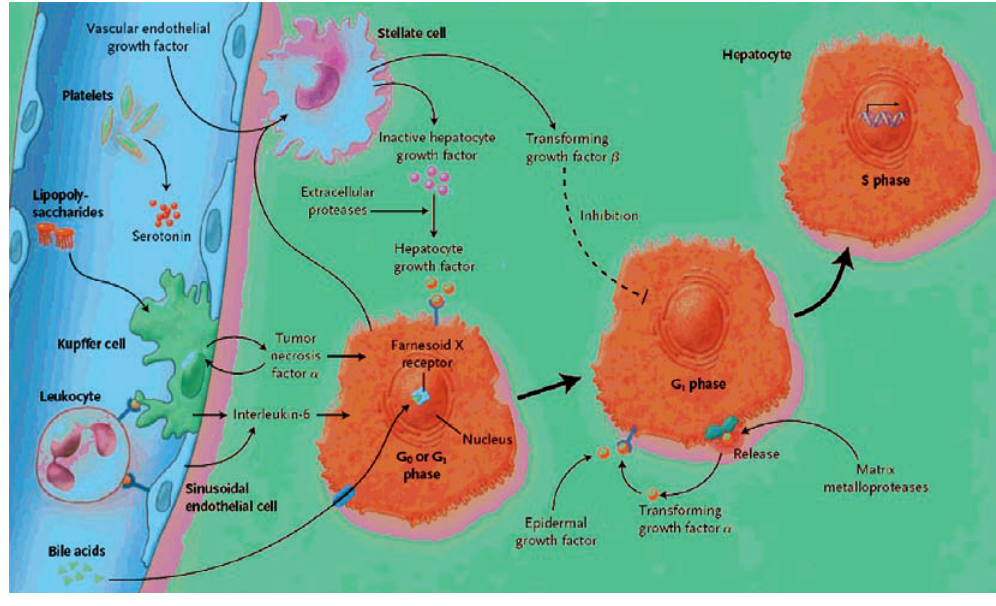
After hepatectomy, nonparenchymal cells, such as stellate cells, Kupffer cells, leukocytes, and platelets, are activated by solu- ble factors such as vascular endothelial growth factor and lipopolysaccharide. Interaction between activated vascular compo- nents, including platelets, leukocytes, sinusoidal endothelial cells and Kupffer cells, results in the release of tumour necrosis factor a , interleukin-6, and serotonin. The cytokines cause priming of the remnant hepatocytes and, concurrently, extracellular proteases such as urokinase-type plasminogen activator convert inactive hepatocyte growth factor to its active form. Inactive hepatocyte growth factor, which is secreted by stellate cells, is a mitogen that induces hepatocyte proliferation. Matrix metal- loproteases convert membrane-bound transforming growth factor a into the soluble form. In an autocrine loop, transforming growth factor, along with endothelial growth factor, signals through the endothelial growth factor receptor. The cytokines and the growth factors act in concert to initiate the reentry of quiescent hepatocytes (in the G 0 phase) into the cell cycle from the G 1 phase to the S phase, resulting in DNA synthesis and hepatocyte proliferation. To signal the end of proliferation, trans- forming growth factor b blocks further replication. The metabolic load resulting from the loss of hepatocytes is indicated by the accumulation of bile acids in the blood. The bile acids enter the hepatocytes and drive bile acid receptors such as the farnesoid X receptor, resulting in increased protein and DNA synthesis [Adapted from: Clavien PA, et al. Strategies for safer liver surgery and partial liver transplantation. N Engl J Med. 2007;356(15):1545–59; © 2007 Massachusetts Medical Society. All rights